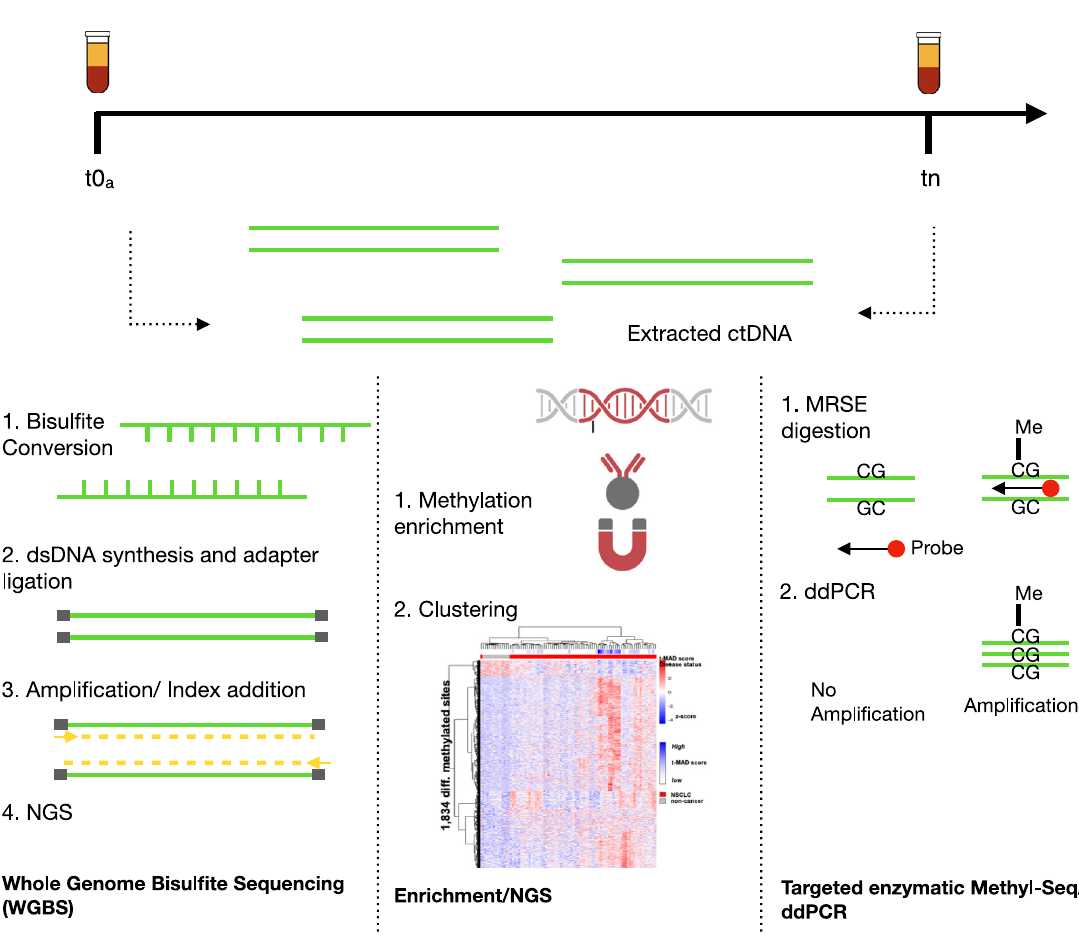
Figure 3: Illustration of the methylation techniques applied within the consortium. Samplesfromt0 a andtnareprocessedandanalyzedwithWholeGenomeBisul fi teSequencing(leftpanel),antibodyenrichment/NGSMetSeq (middle panel), or targeted enzymatic Methyl-Seq/ddPCR (right